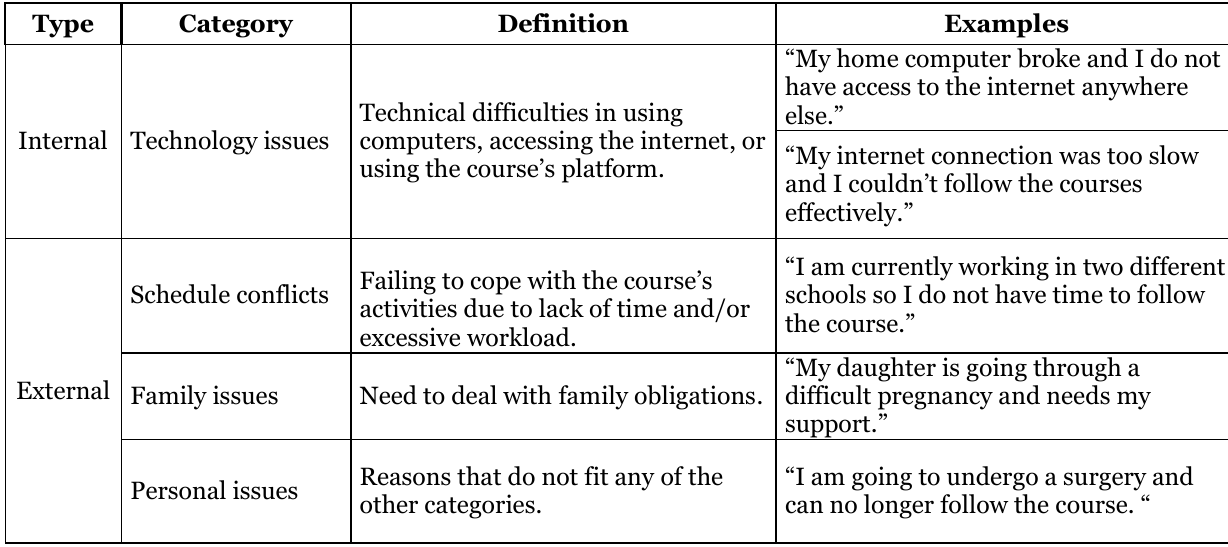
Categories of Teachers’ Answers to E-mail Messages or Phone Calls